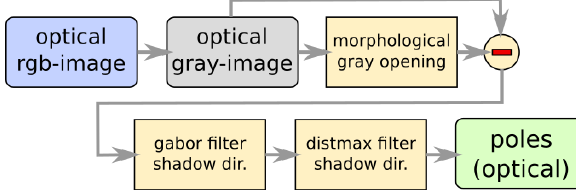
Figure 6. Principle of the detection and extraction of poles from optical